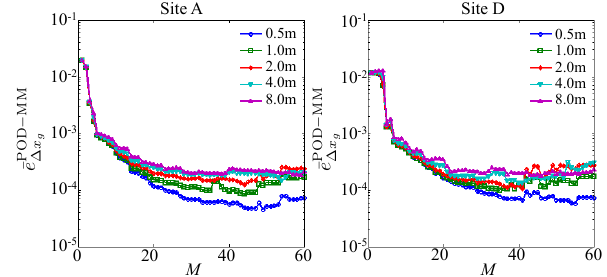
Figure 13. The variation of mean POD-MM error ( ¯ e POD - MM ) 1x g respect to M for different 1x g at sites A and D in 2006. Results are shown for multi-site ROM constructed using POD-MM